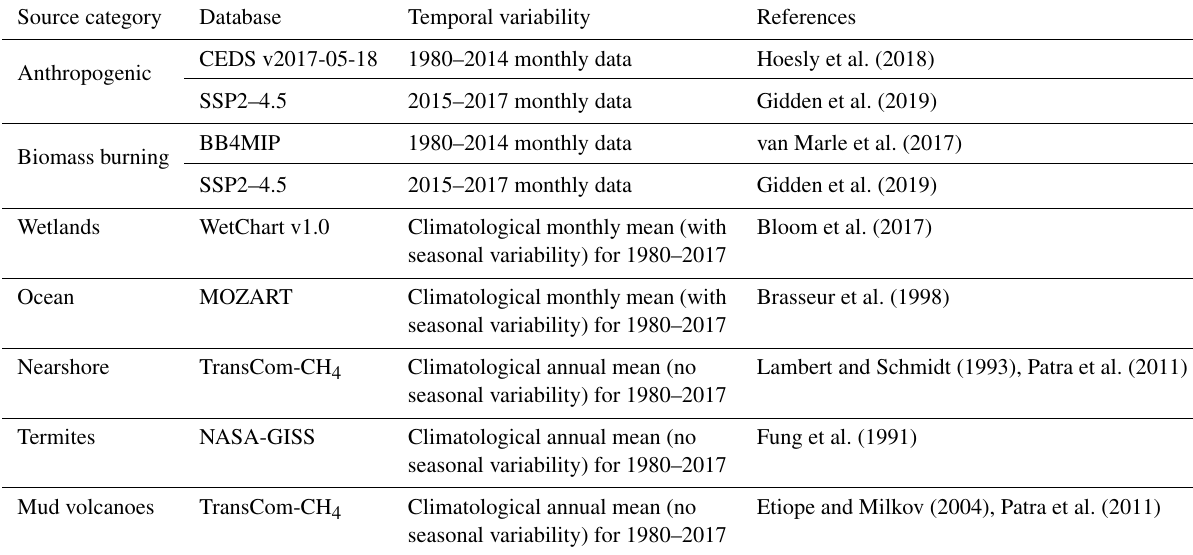
Table 1. Emission inventories used in this